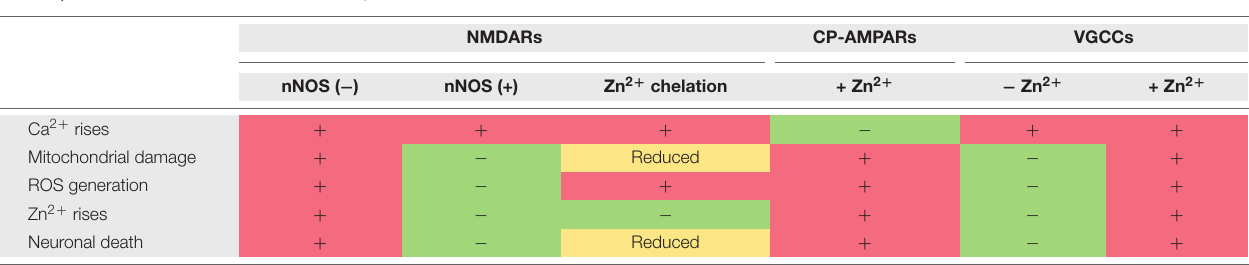
The table compares the excitotoxic cascade-related changes occurring in neurons upon NMDAR activation in nNOS ( − ) and nNOS (+) neurons as well as in neurons in which Zn 2 + mobilization is halted with a metal chelator (i.e., TPEN). The table also compares changes produced by neuronal depolarization, a maneuver that triggers massive Ca 2 + entry through VGCC but is devoid of neurotoxic effects, and CP-AMPAR activation. Note that, unlike Ca 2 + , Zn 2 + influx through VGCC mimics the excitotoxic cascade-related changes. In addition, the activation of CP-AMPAR in the presence of extracellular Zn 2 + shows greater and long-lasting damaging effects when compared to experiments performed in the presence of physiological Ca 2 + levels (Sensi et al., 1999b). Red, yellow, and green boxes indicate a significant change, a moderate change, and no change, respectively, in the parameters listed in the first